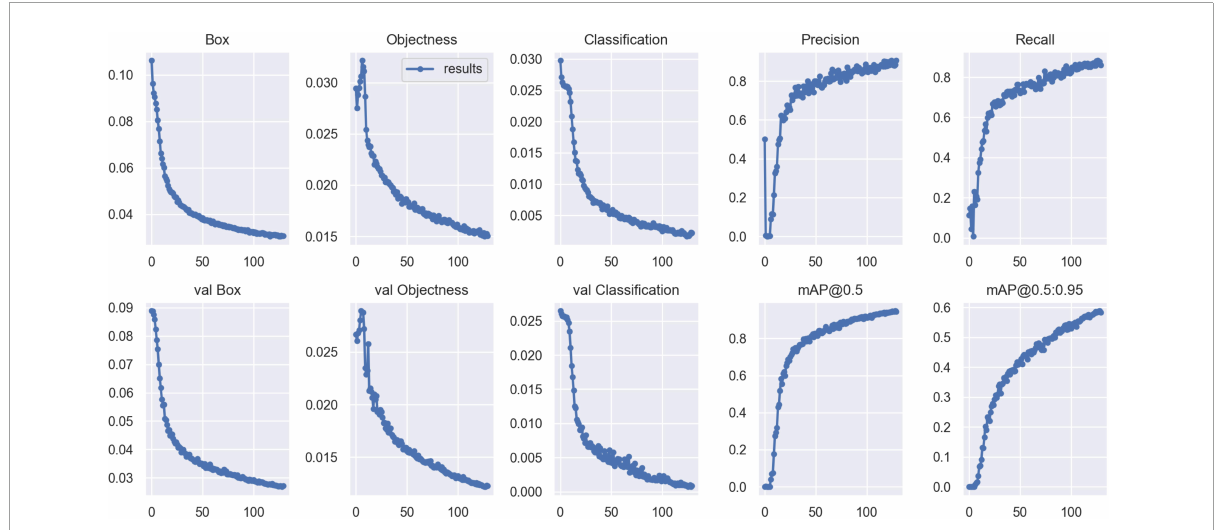
FIGURE4 Validation metrics for SE-YOLO V5. The horizontal axis denotes the number of iterations.